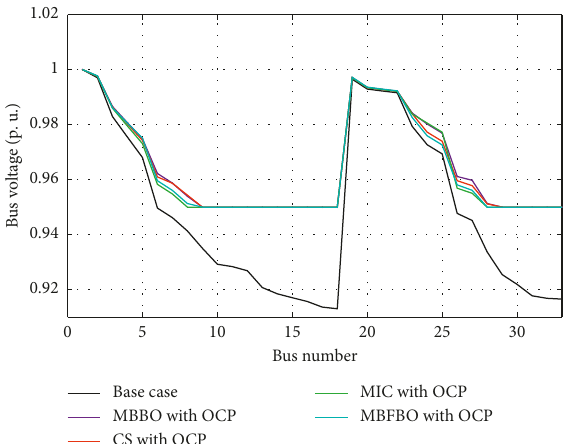
Figure 3: Voltage profile for 33-bus RDS using OCP technique.